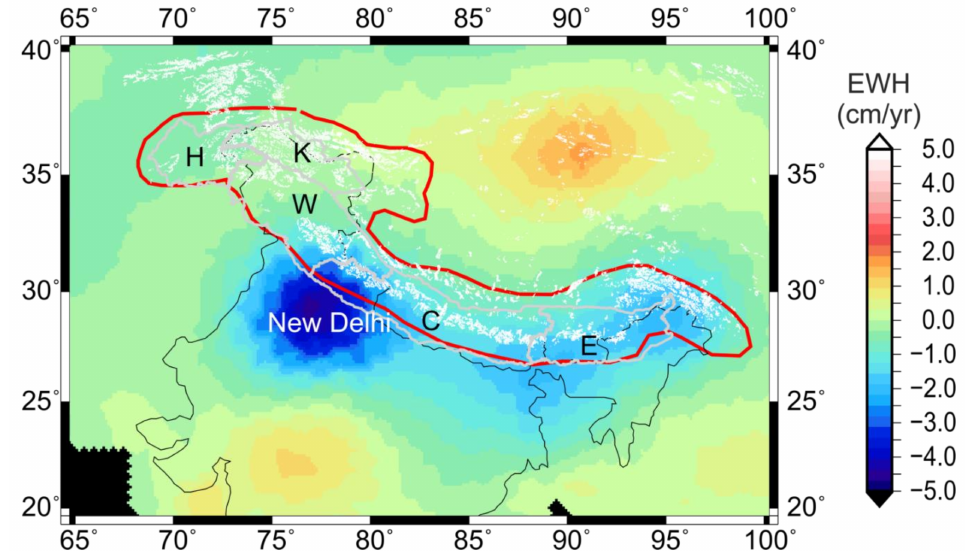
Figure 2. GRACE (Gravity Recovery and Climate Experiment) mass trend over the Himalayan Glaciated Region (HGR) and the surrounding region. Glaciers are represented as white dots (data source: World Glacier Monitoring Service, Boulder, CO, USA), the Himalaya boundary in grey, and the modified boundary used in this paper in